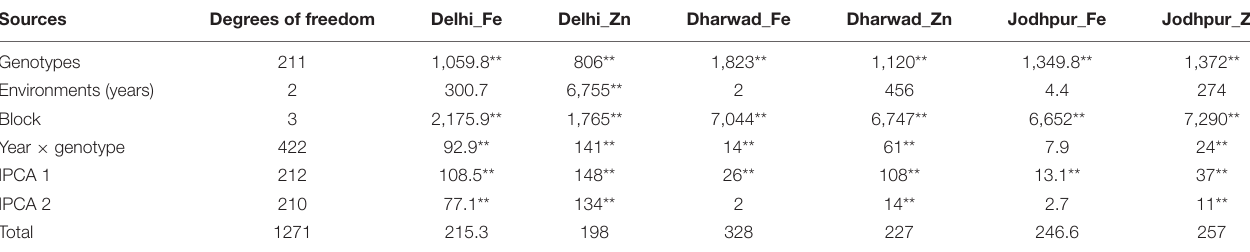
TABLE 5 | Mean sum of square of Fe and Zn at all locations based on combined analysis over three years for RILs and parents. Sources Degrees of freedom